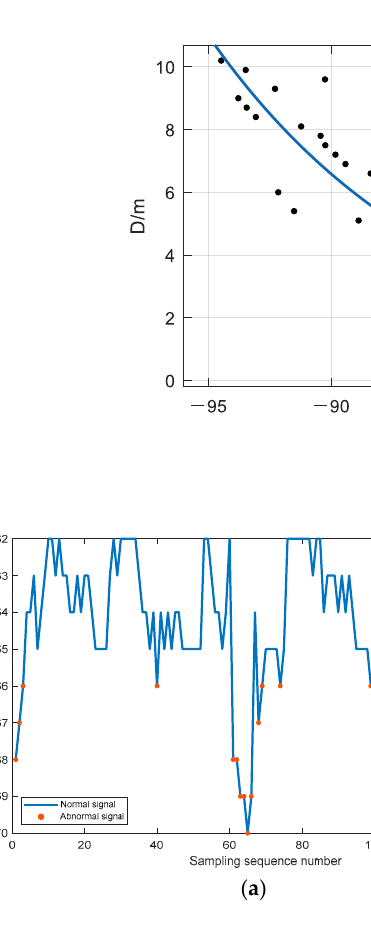
Table 3. iBeacons’ MAC and Coordinates.